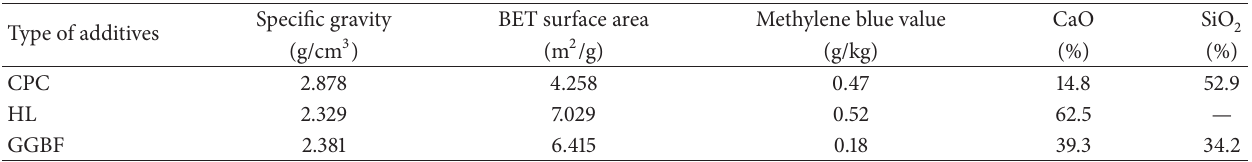
Table 3: The basic properties of chemical